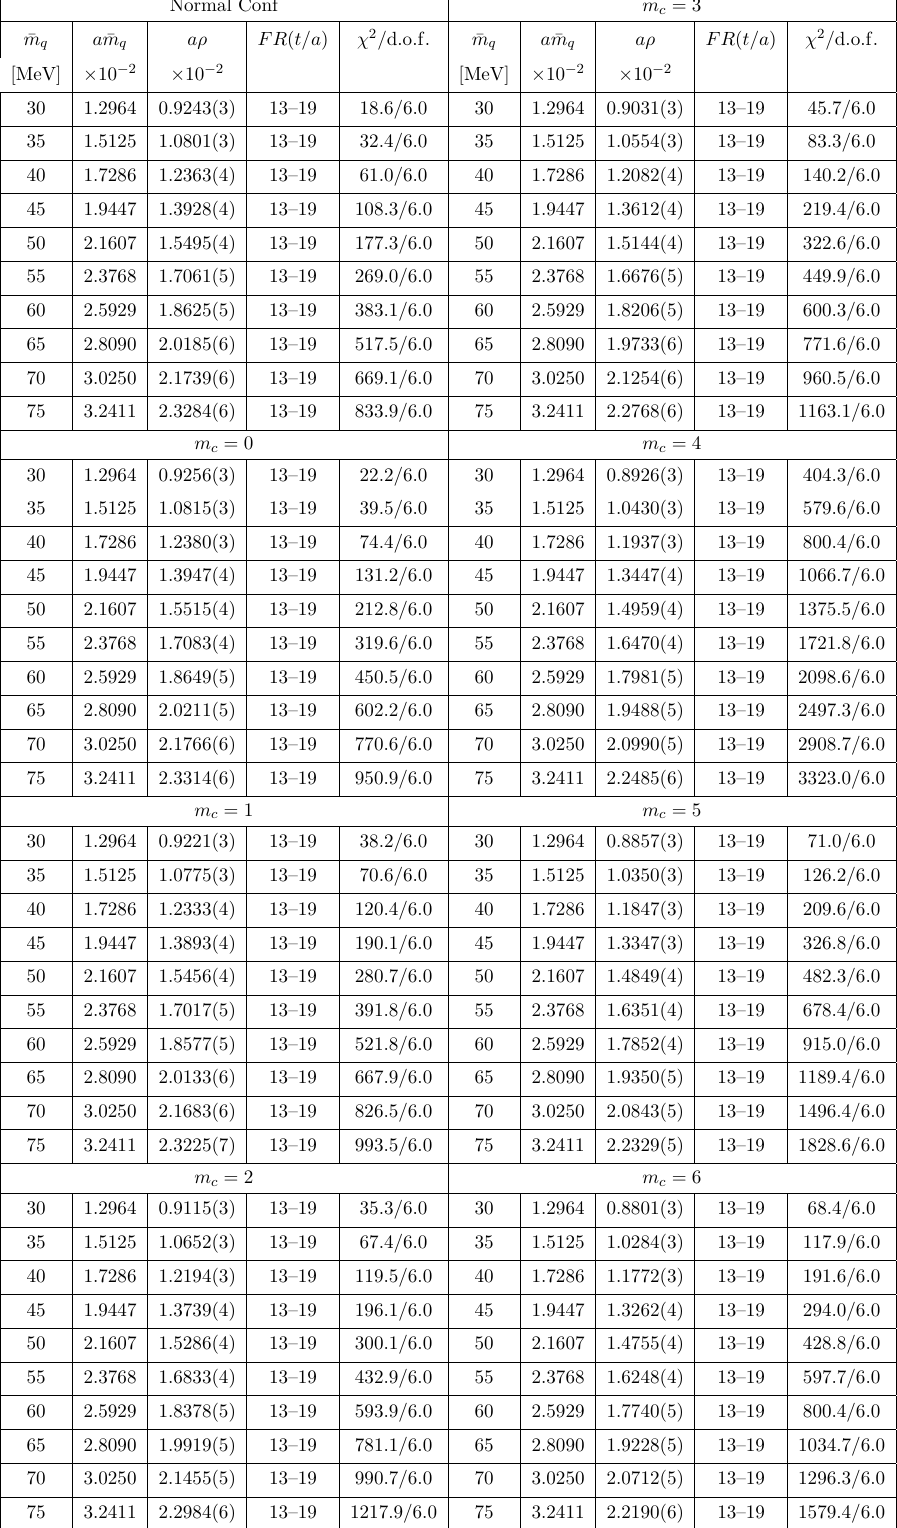
Table 28 . The (cid:12)tting results of a(cid:26)